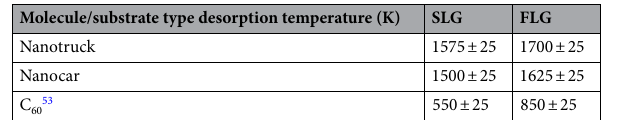
Table 2. Estimated desorption temperatures (K) in 4 studied systems and an isolated C 60